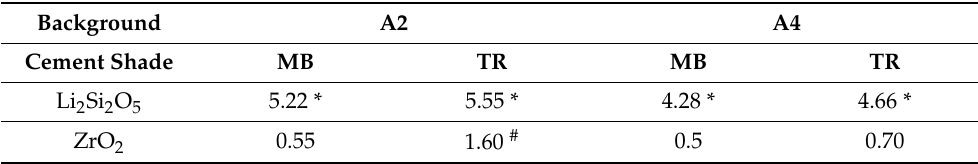
Table 5. ⊗ E 00 values of MB and TR vs. control group. Values above acceptability (1.8) and percepti- bility (0.8) threshold are outlined (* #